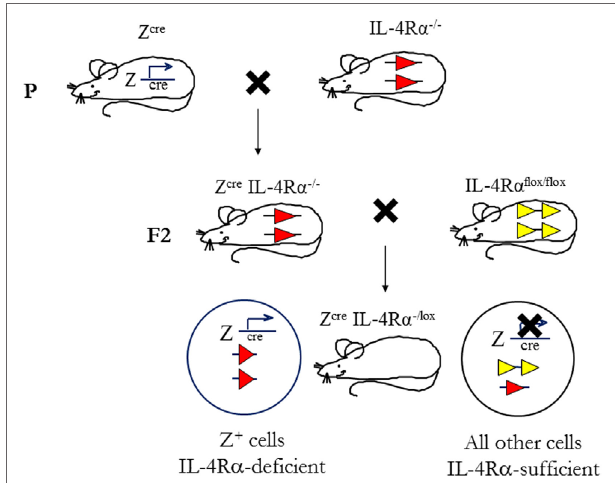
FiGURe 4 | Mouse breeding strategy to create cell-specific interleukin-4 receptor alpha (IL-4R α )-deficient mice. IL-4R α flox/flox BALB/c mice were intercrossed with transgenic mice expressing Cre-recombinase under control of a cell-specific promoter (Z cre ) and IL-4R α − / − BALB/c mice to generate Z cre IL-4R α − /lox mice. The “loxed” IL-4R α allele, yellow arrows; deleted allele, red arrows. Illustration adapted and redrawn from previous publications (10, 11,